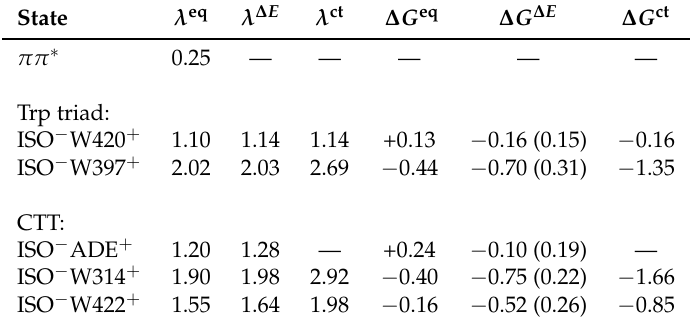
Table 1. Driving force ∆ G and reorganization energy λ (in eV) evaluated from ground state equilibrium configurations ( λ eq , ∆ G eq ), parabolic fitting of free energy curves ( λ ∆ E , ∆ G ∆ E ), and CT state configurations ( λ ct , ∆ G ct ) , cf. Materials and Methods, Section 4.2 for details, errors given in parenthesis.